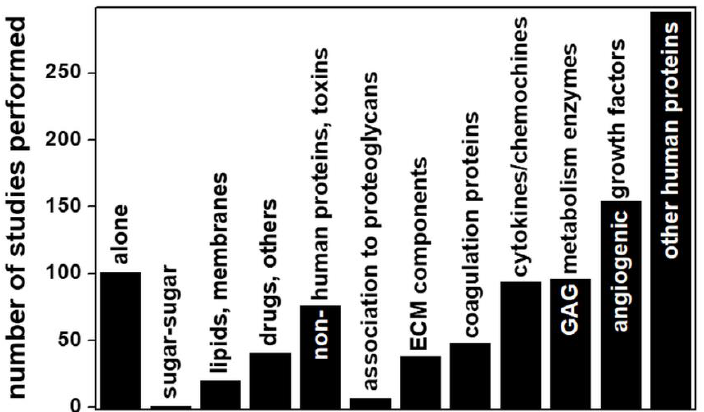
Figure 11. Distribution of computational structural studies of GAG alone and of GAGs complexed with the indicated ligand. For further details on the bibliographic research strategy, see Appendix A.